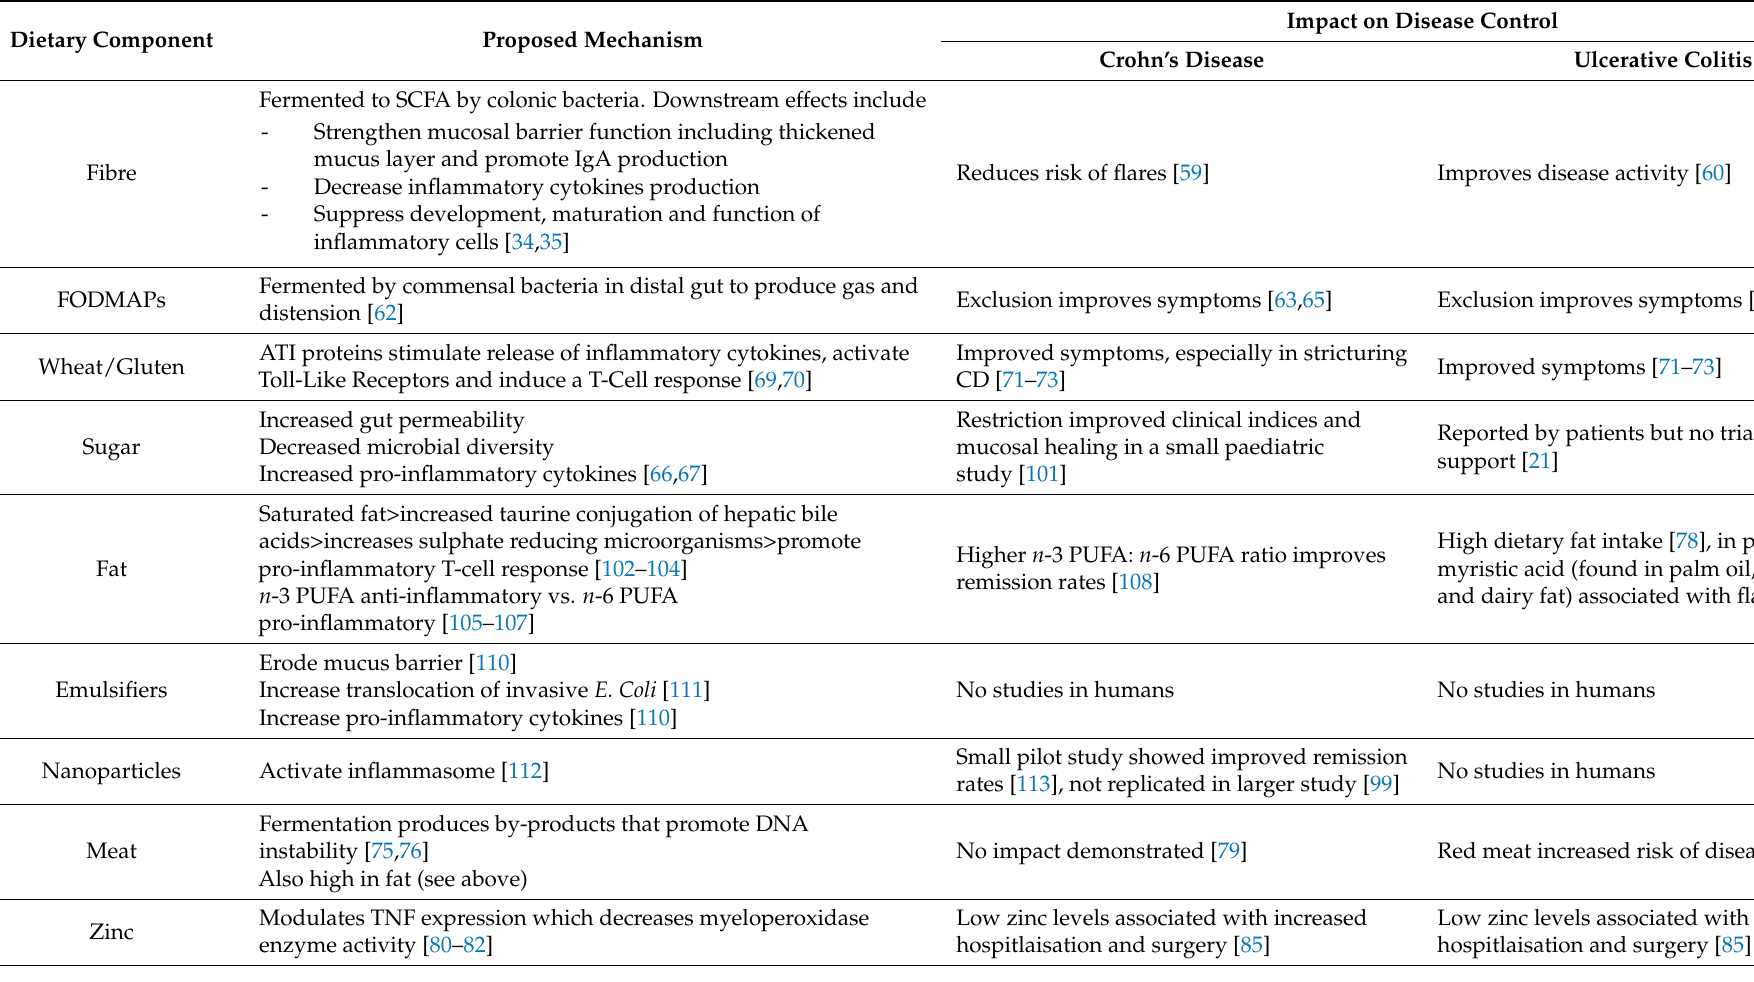
Table 2. Dietary components, proposed mechanism of influence and impact on disease